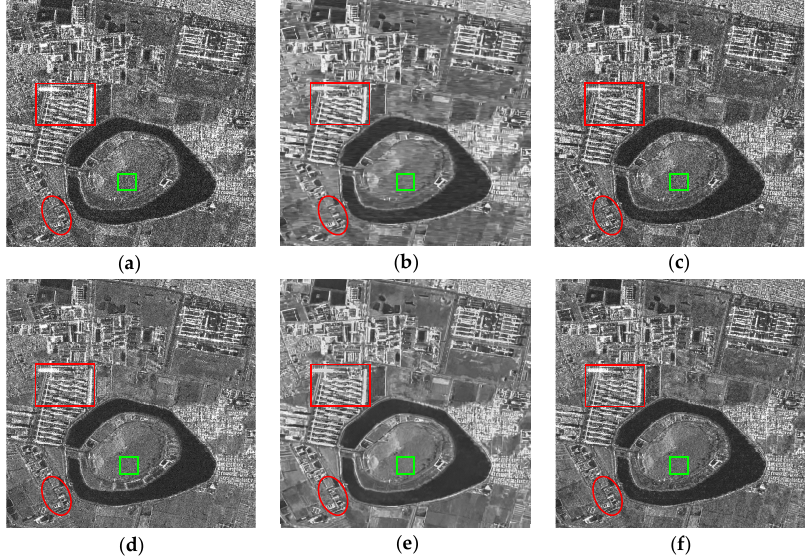
Figure 11. Filtering results for Dataset 2: ( a ) Original image (28 March 2012); ( b ) FANS; ( c ) QF; ( d ) CDMF; ( e ) MSAR_BM3D; ( f ) the proposed approach.